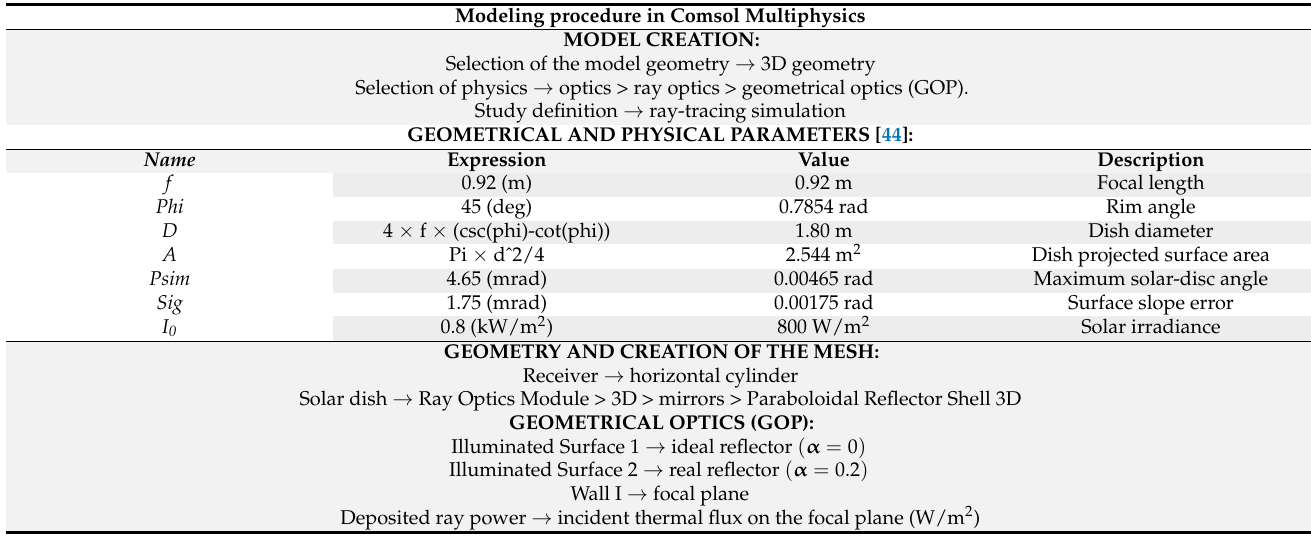
Table 1. Geometrical and physical parameters used in the study and scheme of the multiphysical model. Modeling procedure in Comsol Multiphysics MODEL CREATION: